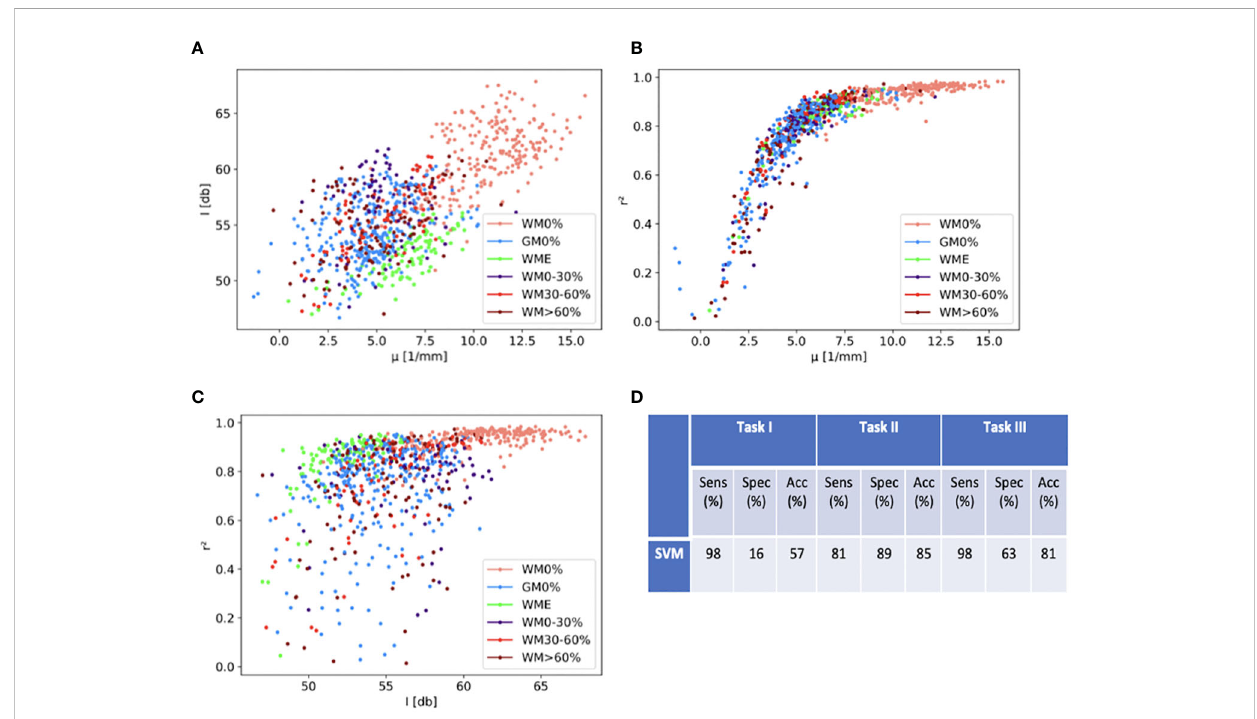
FIGURE 5 Scatter plots of extracted optical properties in regard to tissue labels (GM0%, gray matter with 0 tumor in fi ltration; WM0%, white matter with 0% tumor in fi ltration; WM0-30%, white matter with 0-30% tumor in fi ltration; WM30-60%, white matter with 30-60% tumor in fi ltration; WM>60%, white matter with >60% tumor in fi ltration and WME, white matter with edema). (A) shows backscatter intensity against attenuation coef fi cient, (B) displays attenuation coef fi cient against fi tted measured r2, (C) shows backscatter intensity against fi tted measured r2. (D) shows results for sensitivity (Sens), speci fi city (Spec) and balanced accuracy (Acc) for speci fi c classi fi cation tasks with support vector machine (SVM) classi fi cation. Task I includes full data, Task II includes classi fi cation of tumor in fi ltration in white matter (excluding GM0% and WME) and Task III includes classi fi cation of highest tumor in fi ltration grade in white matter (excluding GM0%, WME, WM0-30% and